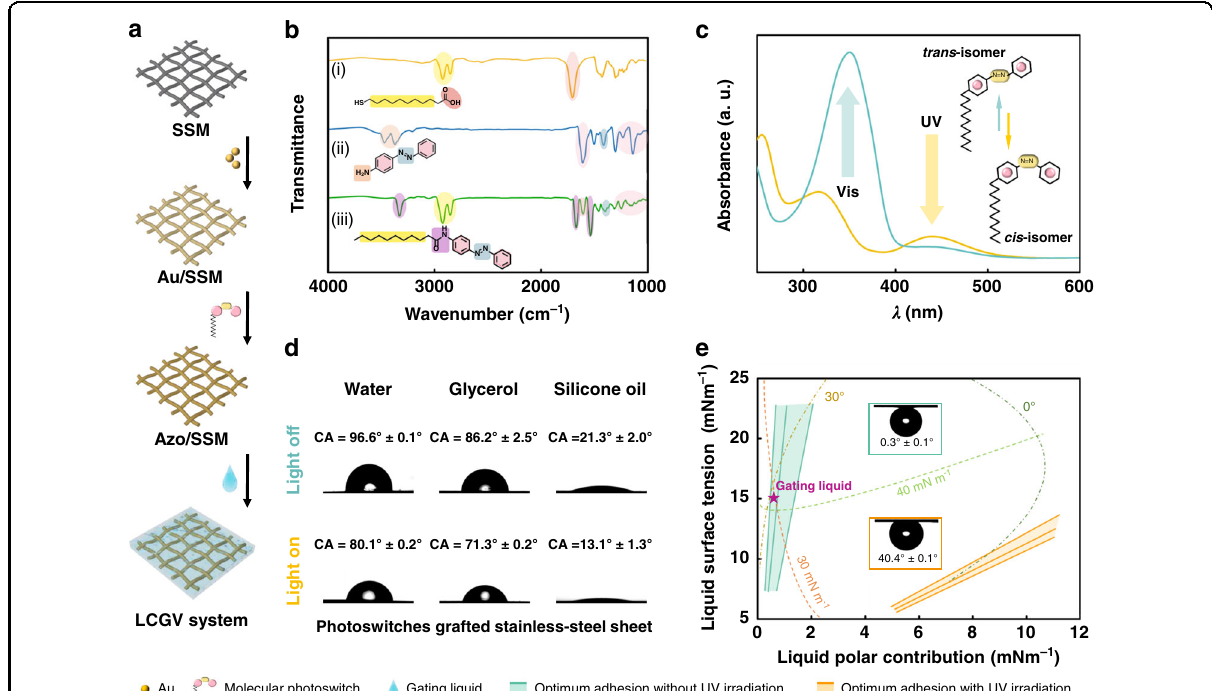
Fig. 2 Design, evaluation and adhesion mechanism of LCGV system. SSM, Au/SSM, and Azo/SSM represent the stainless-steel membrane, Au-ion sputtered stainless-steel membrane, and azobenzene-based molecular photoswitches grafted stainless-steel membrane. a Interfacial design and preparation of the LCGV system. b Infrared spectra demonstrate the successful synthesis of azobenzene-based molecular photoswitch. c UV-vis absorption spectra of the azobenzene-based molecular photoswitch with trans and cis forms. Inset shows the photoisomerization process of the molecular photoswitch. d The wettability of different liquids on photoswitches grafted stainless-steel sheet with and without UV irradiation. e The solid – liquid interfacial adhesion mechanism of the LCGV system. Insets show the bubble contact angles on photoswitches grafted stainless-steel sheet immersing in gating liquid with and without UV